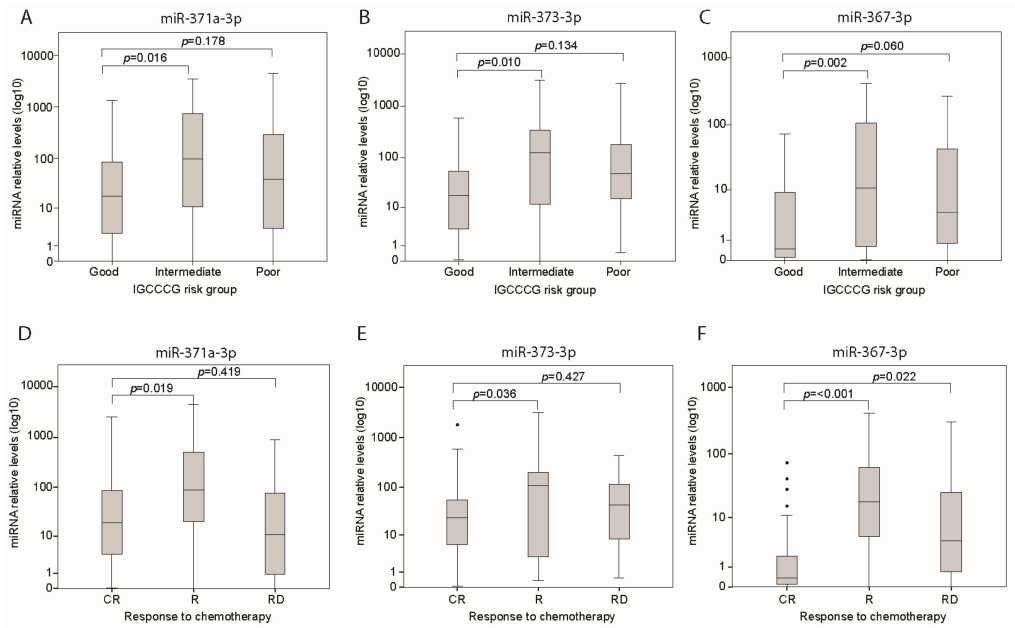
Figure 3. Relative levels of miR-371a-3p ( A ), miR-373-3p ( B ) and miR-367-3p ( C ) before start of chemotherapy in cohort 1 and 2 combined in good ( n = 67), intermediate ( n = 25) or poor risk ( n = 17) IGCCCG group. Relative levels of miR-371a-3p ( D ), miR-373-3p ( E ) and miR-367-3p ( F ) before start of chemotherapy in cohort 1 and 2 with complete response (CR, n = 60), relapse (R, n = 34) or refractory disease (RD, n = 15). The parameter p denotes Mann Whitney U test